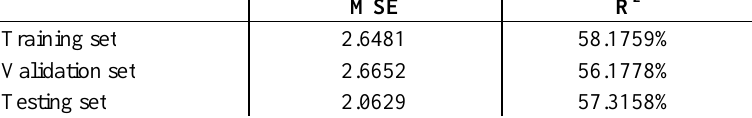
Table 2 – Results of neural network with 15 neurons in hidden layer